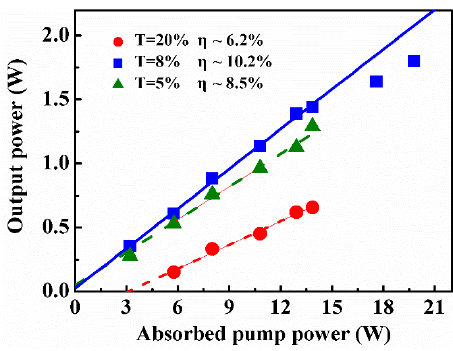
Figure 2. Continuous-wave (CW) output power vs. absorbed pump power with different output